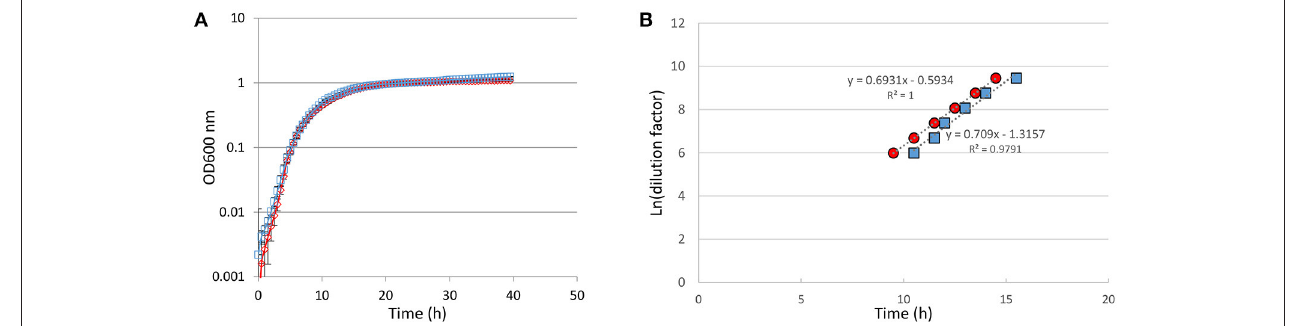
FIGURE 2 | Growth comparison between P. luminescens overexpressing dam gene (red) and control harboring an empty plasmid (blue). (A) Growth curves in LB of the P. luminescens Dam-overexpressing strain and control strain (inoculated at 1.61 × 10 5 and 1.86 × 10 5 CFU/ml, respectively). Mean values ± SDs of at least 3 independent biological replicates for each strain are shown. (B) Two-fold serial dilutions of cultures containing 1.25 × 10 4 CFU/ml for each strain have been performed in LB. Growth was quantified by absorbance at 600nm and measured every 30min. Four independent biological replicates for each strain were used. The time of growth detection was defined as an increase of 0.1 unit of absorbance at 600 nm, and recorded for each dilution. The Ln of the dilutions as a function of the time for growth detection is indicated. Similar slopes indicate similar growth rates (see Methods section for details). Differences were not significant ( p = 0.92, Student t